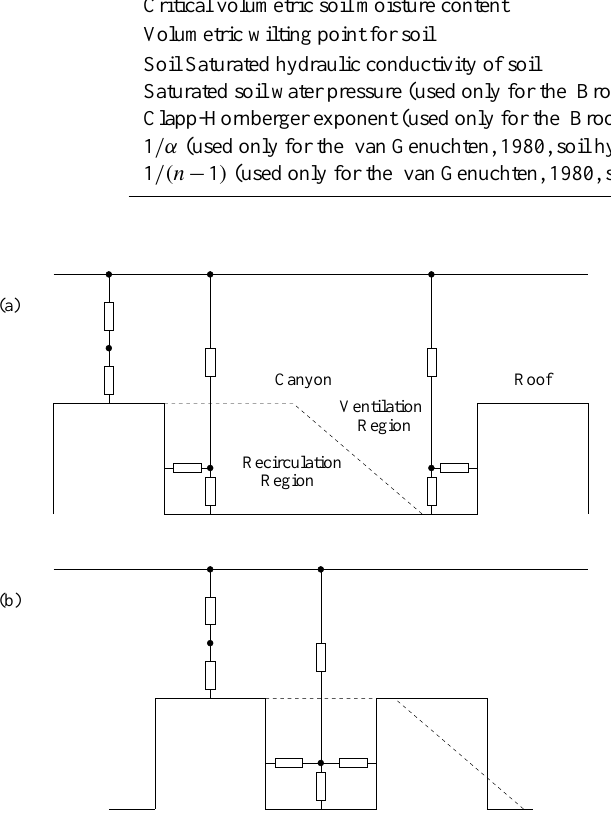
Fig. 2. The two dimensional canyon geometry used in MORUSES illustrating the resistance network used in the parametrisation of the roughness length for heat. The panels depict: (a) a wide canyon geometry with both ventilation and recirculation regions; and (b) a narrow canyon with only a recirculation region (adapted from Fig. 3 of Harman et al., 2004)